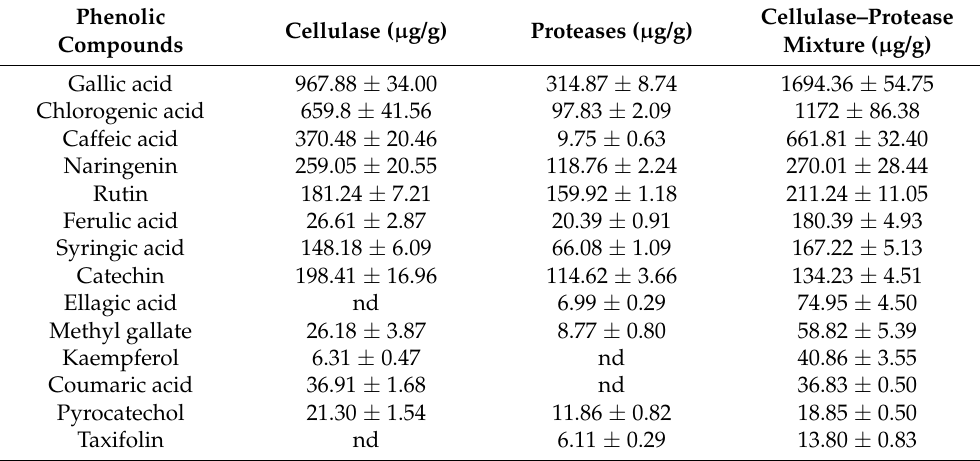
Table 2. Phenolic compounds in corn tassel extract by enzyme-assisted method. Phenolic Cellulase ( µ Compounds